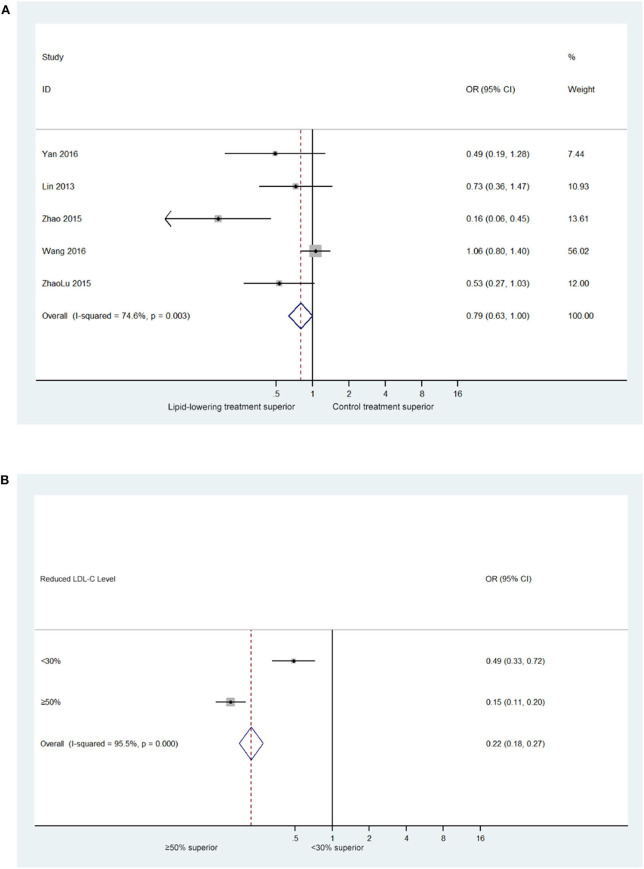
(A) Forest plot of estimated relative risk of stroke recurrence in trials of lipid-lowering treatment (5 trials with 1,821 ischemic stroke patients). (B) Standardized associations between LDL-C reduction and relative risk of stroke recurrence (5 trials with 371 ischemic stroke patients who experienced LDL-C reduction by 30–50%).